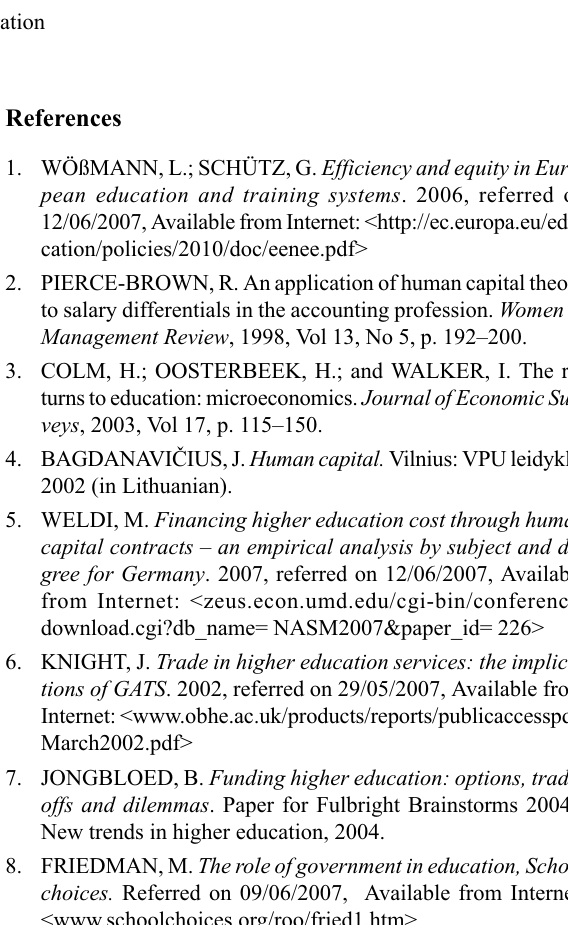
Fig 1. The management model of high-skilled labour force migration